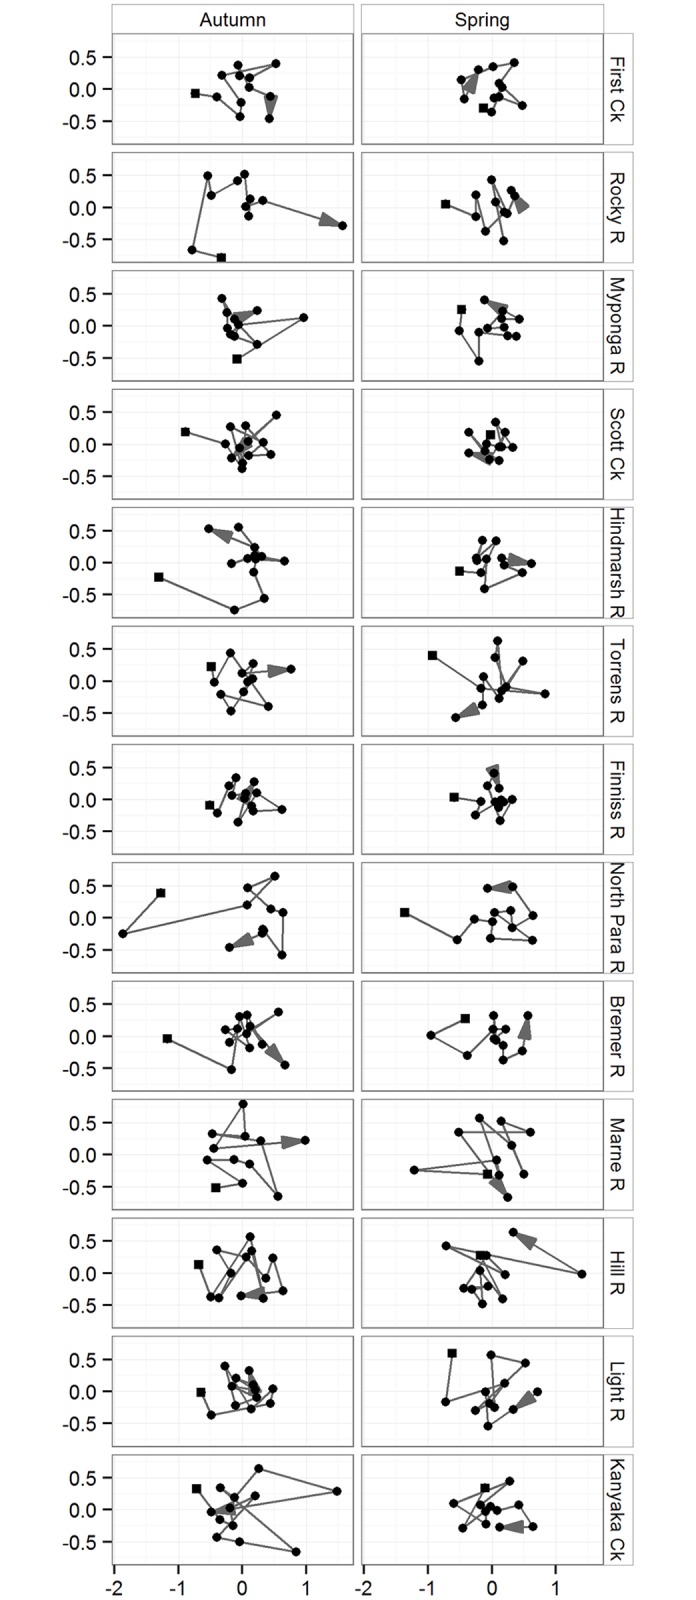
Unconstrained ordination plots of macroinvertebrates in autumn and spring.Unconstrained (semi-strong hybrid MDS) ordination plots of macroinvertebrates (individual sites across years) based on Bray-Curtis similarity of 4th root abundance data in autumn and spring. Sites names with “Ck” and “R” represent creeks and rivers respectively. The lines connecting the dots represent trajectories of assemblage structure across the years. Square symbols indicate the start of the trajectory and the arrow head indicates the end of the trajectory. The scale represents dissimilarity of sites.